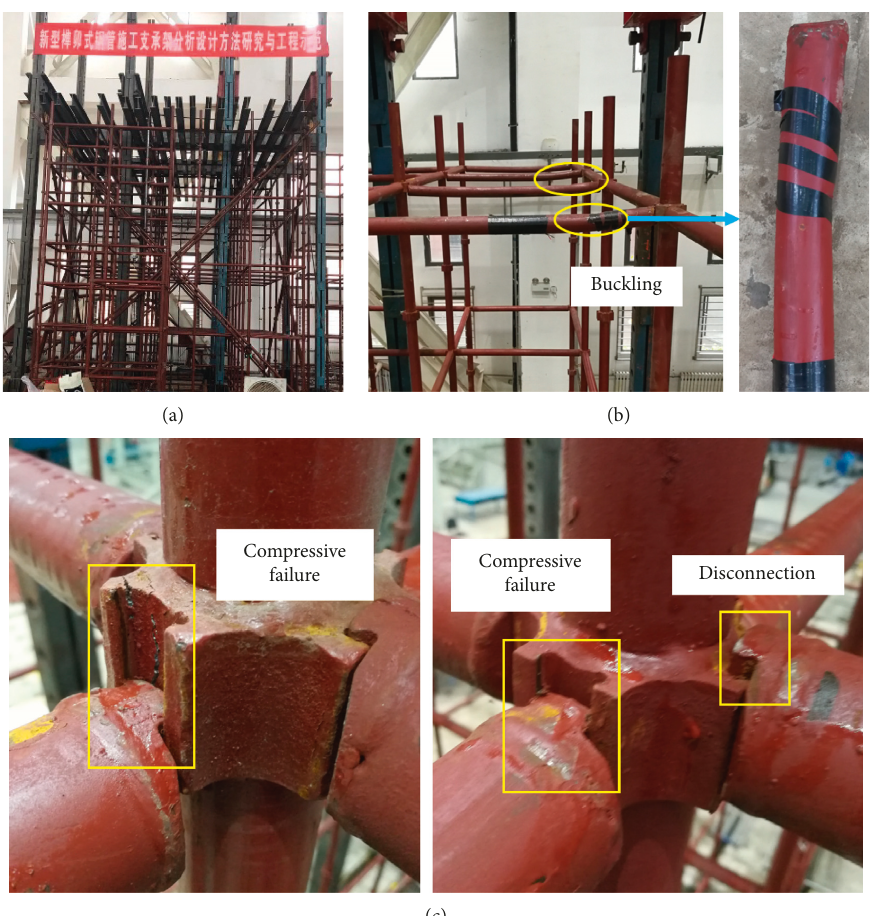
Figure 18: Failure situations of Model 5. (a) Overall buckling deformation of the scaffold. (b) Deformation of horizontal rods in the loading area. (c) Failure of a top fastener.